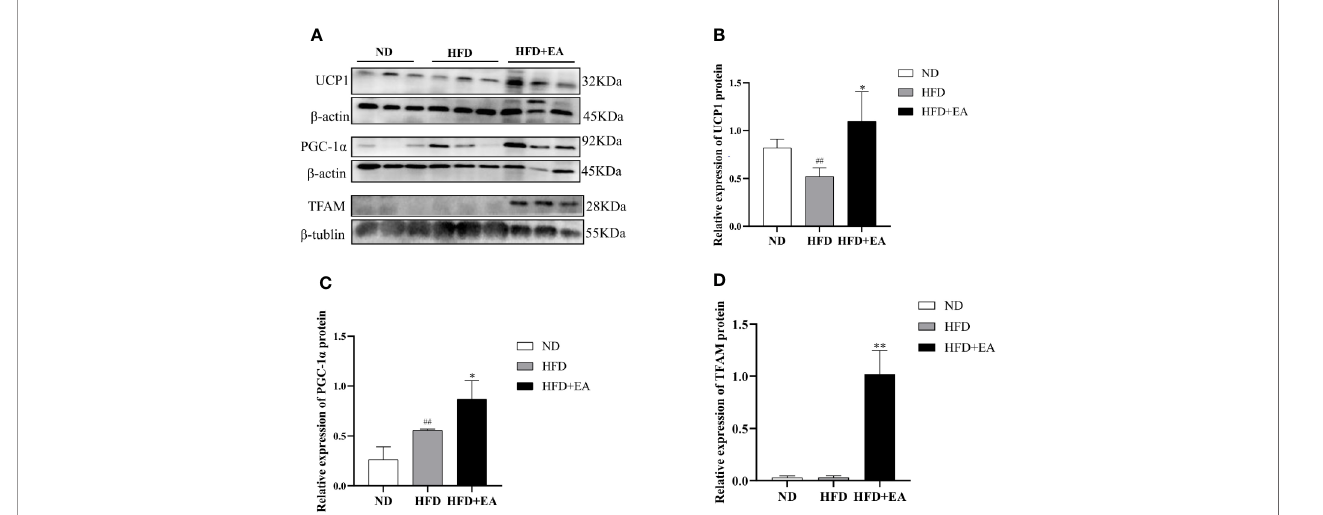
FIGURE 2 | Effect of EA treatment on mitochondrial biogenesis in IWAT from ND, HFD or HFD+EA group. Western blot image of UCP1, PGC-1a and TFAM (A) staining and relative protein levels of UCP1 (B) , PGC-1a (C) and TFAM (D) . Data was represented as mean ± SD (n = 3). ## P < 0.01 vs. the ND group; *P < 0.01, **P < 0.05 vs. the HFD + EA group.